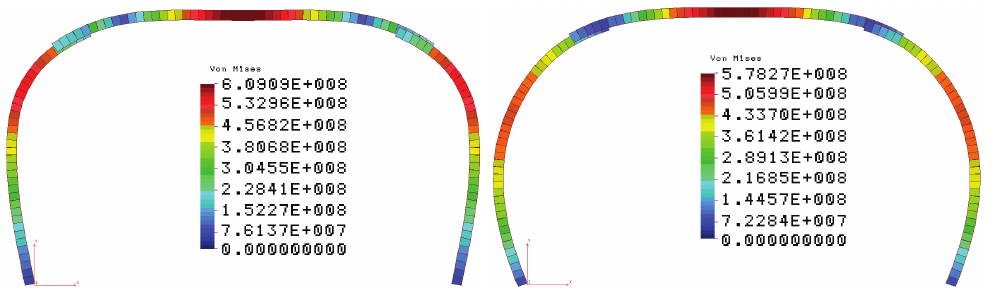
= 0.1 MN/m, stresses in Pa, s